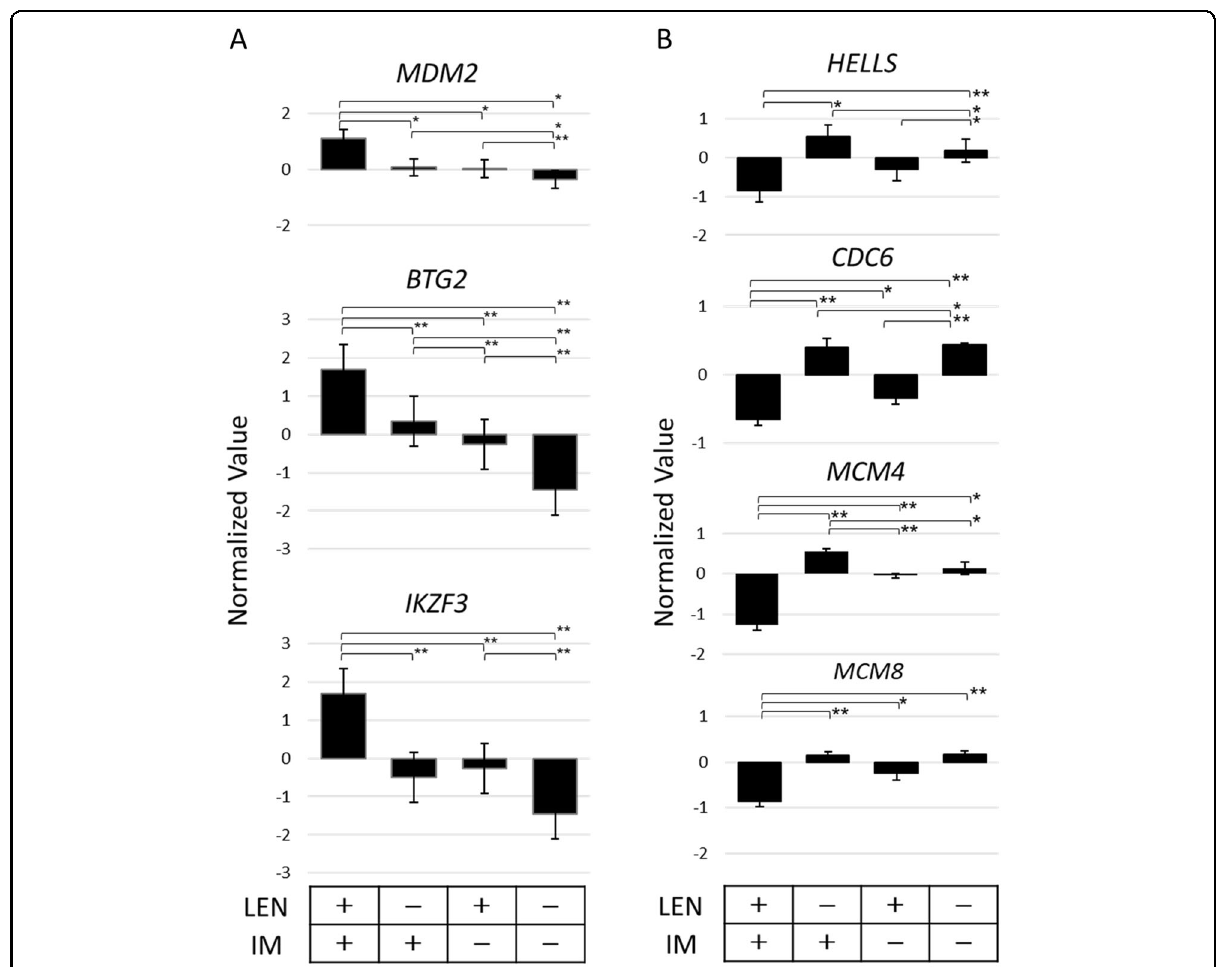
Fig. 6 Array analysis of changes after LEN and IM treatment. KOPN57bi cells were cultured for 24 h in the presence or absence of LEN (5 μ M) or IM (0.5 μ M) alone or both, and harvested. The isolated RNAs were reverse-transcribed and labeled using the GeneChip HT 3 ′ IVT Expression kit (Affymetrix, Santa Clara, CA) as instructed by the manufacturer. The labeled probes were hybridized in triplicate to GeneChip Human Genome-U133 Plus 2.0 Arrays (Affymetrix) as described previously 49 . The arrays were analyzed using GeneChip Operating Software 1.2 (Affymetrix) and GeneSpring GX 14.9 software (Agilent Technologies, Santa Clara, CA). Genes with a p value lower than 0.01 by one-way ANOVA were selected. After performing fold-change analysis, genes that exhibited two times higher or lower expression were selected in each of the culture conditions. By using selected gene lists, single experiment pathway analysis was performed. A Upregulated genes. Among upregulated genes showing 2-fold higher by LEN plus IM treatment than LEN alone treatment, fold changes in RNAs of 3 genes MDM2, BTG2, and IKZF3 were presented in each culture condition. B Downregulated genes. Among downregulated genes showing 2-fold lower by LEN plus IM treatment than by LEN or IM alone treatment, fold changes in RNAs of 4 genes HELLS, CDC6, MCM4, and MCM8 were presented in each culture